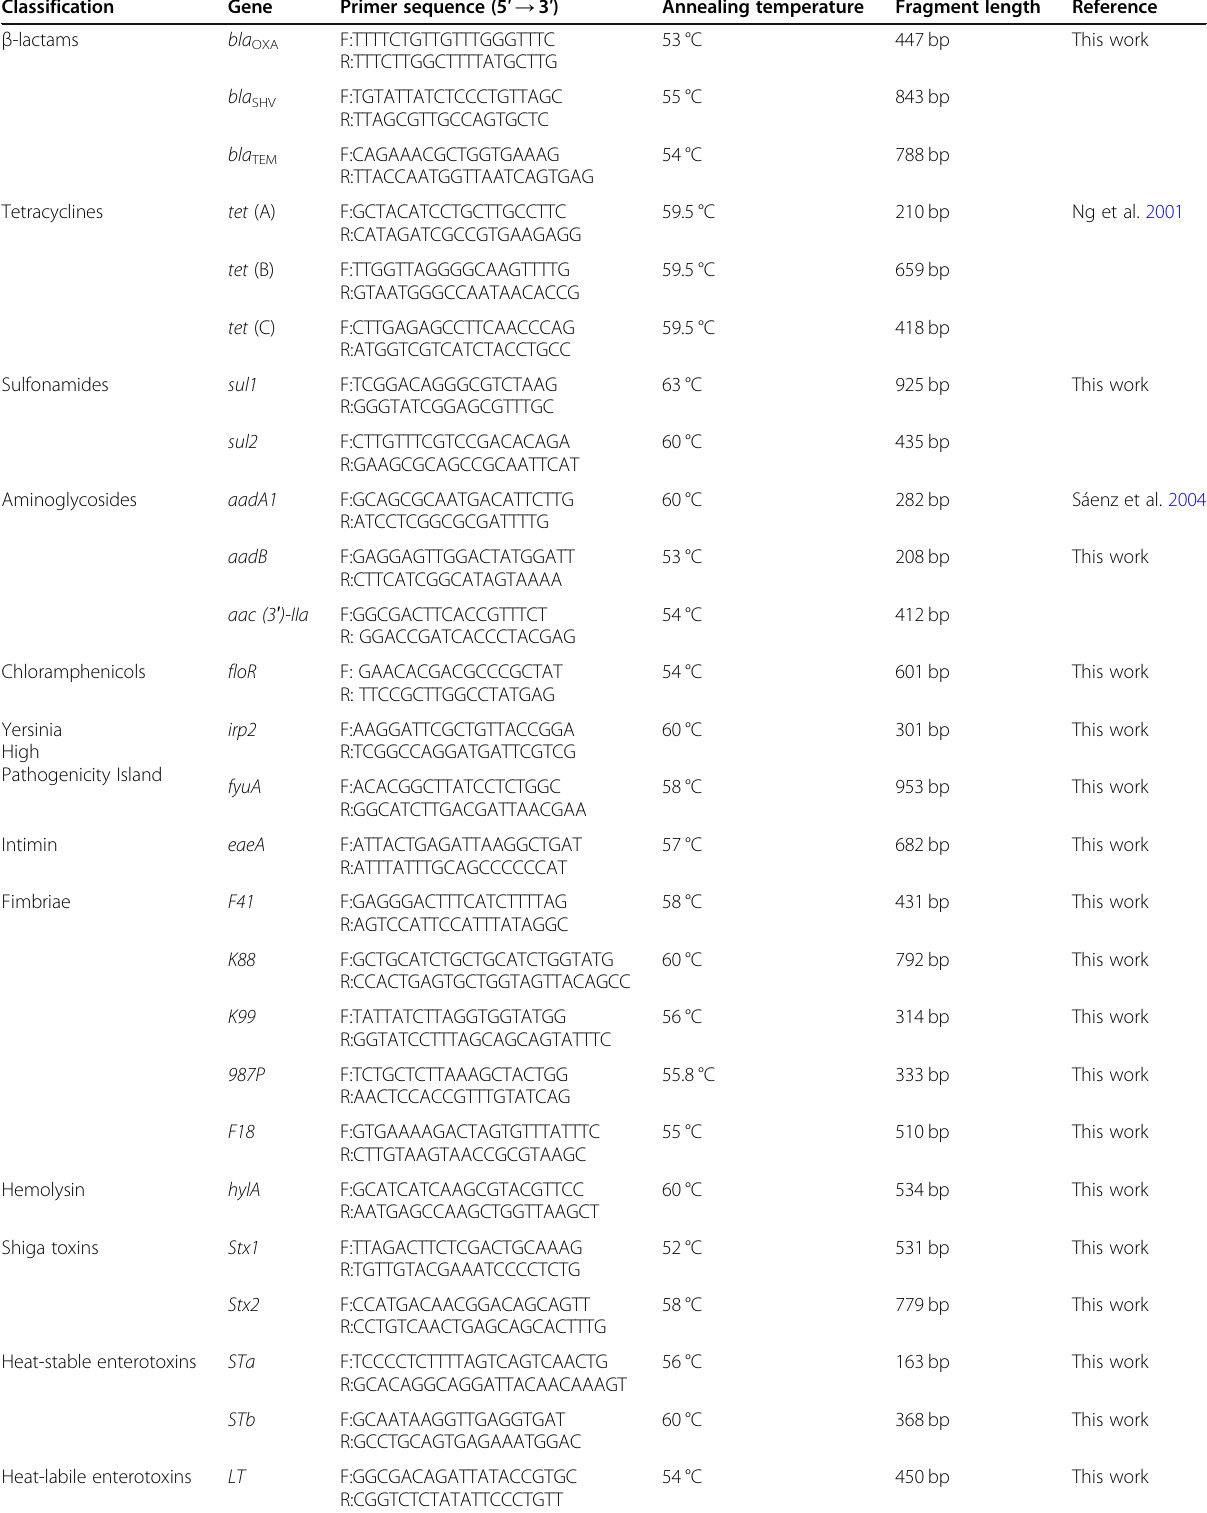
Table 8 Primers of antimicrobial resistance genes and virulence